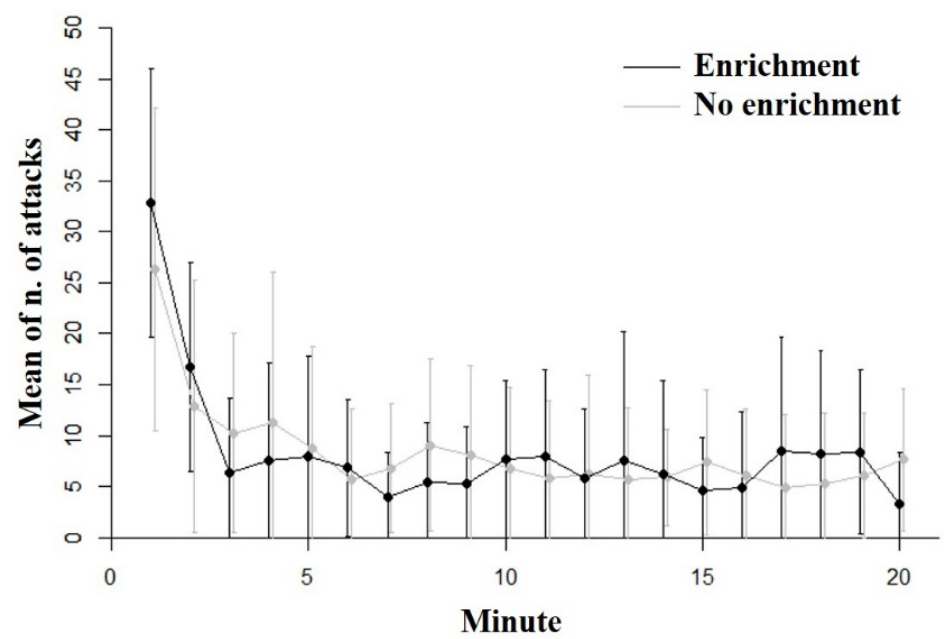
Figure 2. Results of the inhibitory control task. Number of attacks (mean ± SE) performed by the subjects of the two treatments in each minute of the test phase. The black line represents the treatment with environmental enrichment and the grey line the group without environmental enrichment.